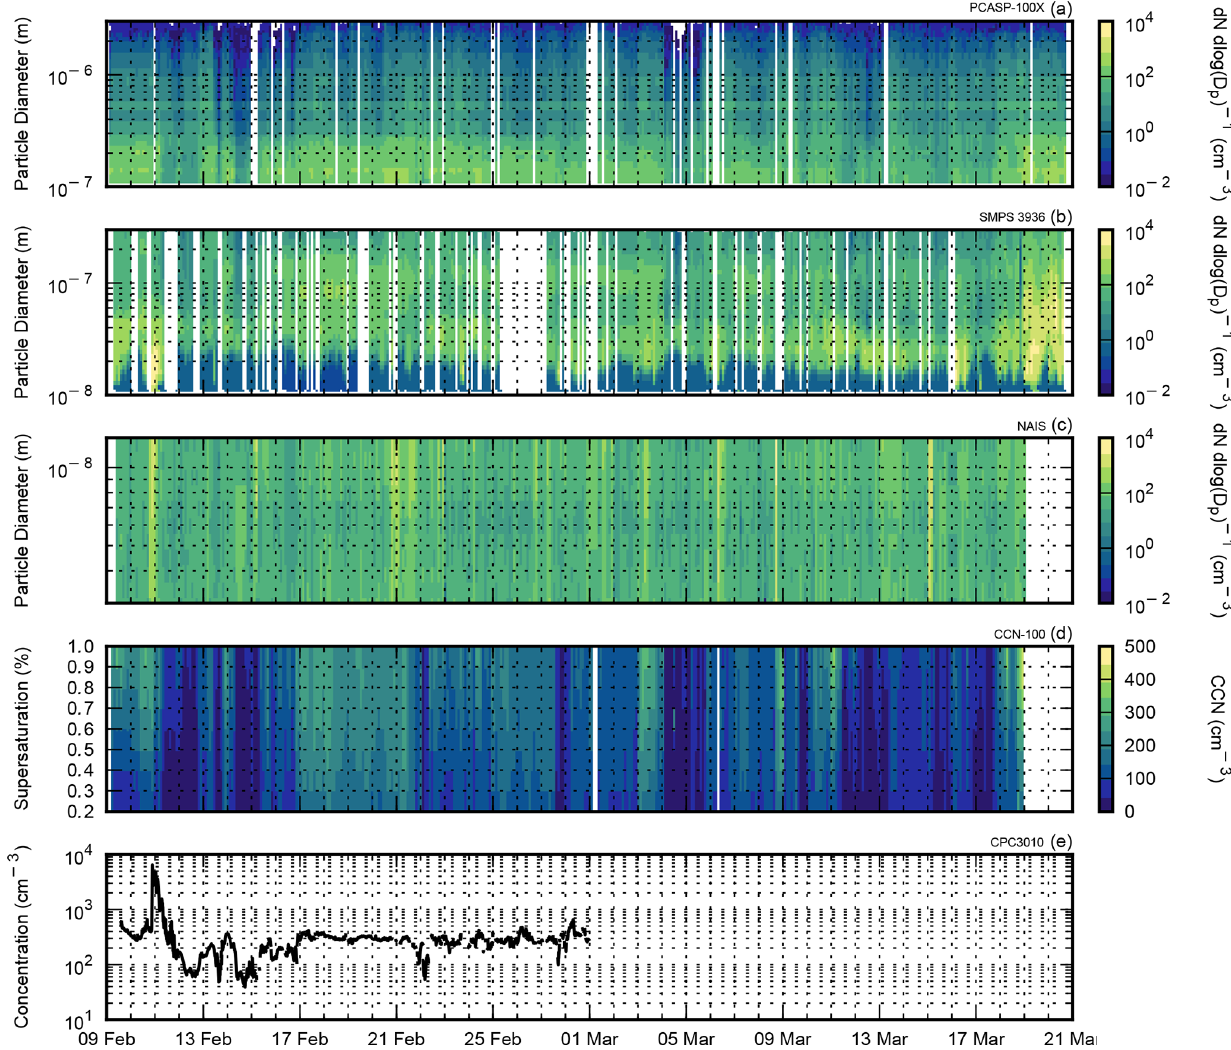
Figure 16. Spectral and total particle concentrations measured by various particle counters throughout the Southern Ocean Ross Sea Marine Ecosystems and Environment voyage. Data gaps resulted from intrusions of polluted air into the sampling line or from instrument/system errors. (a) PCASP-100X, (b) SMPS3936, (c) NAIS, (d) CCN-100, and (e) CPC3010. See Sect. 3.8 for more